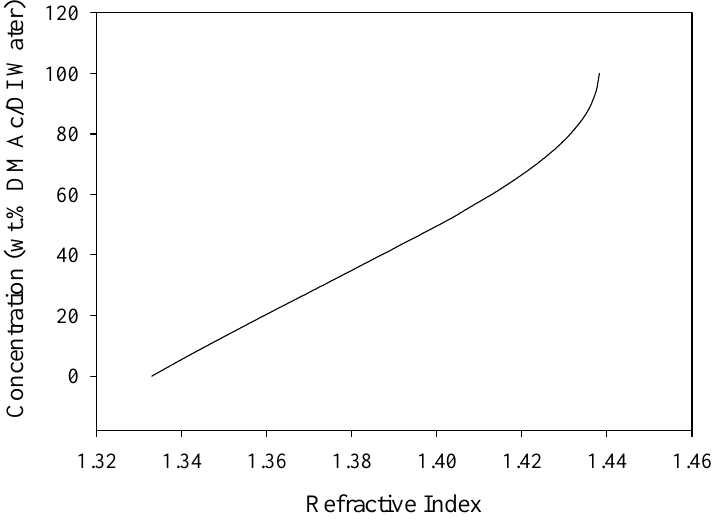
Figure 4. Calibration curve developed using the refractive index for DMAc/H 2 O